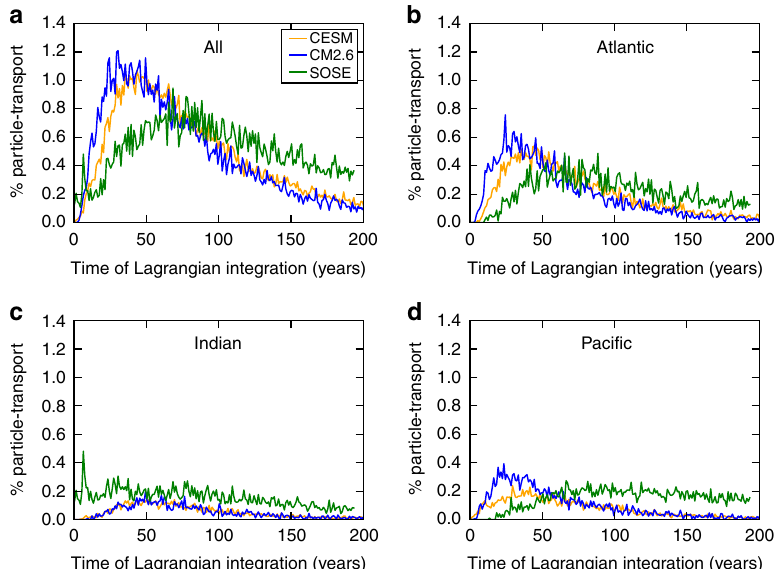
Fig. 4 Particle upwelling timescales. Transit time distribution for particle-transport from 30° S to the mixed layer in the three models for particles originating in a all basins, b the Atlantic, c the Indian, and d the Paci fi boundary currents, but we focus our attention on the mechanism for upwelling hotspots within the ACC.